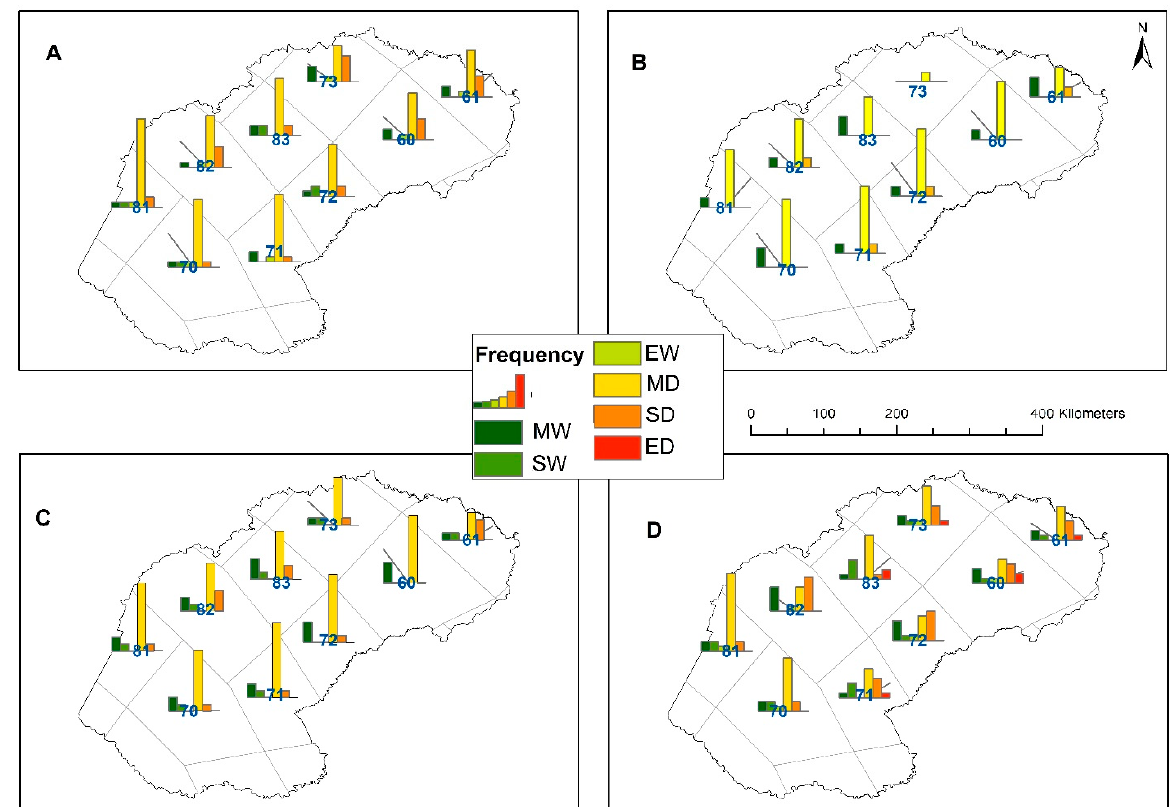
Figure 12. Frequency of EDI, SPI-3, SPI-6, and SPI-12 in the Free State Province from 1980 to 2019: ( A ) EDI; ( B ) SPI-3; ( C ) SPI-6; ( D ) SPI-12 (MW, moderately wet; SW, severely wet; EW, extremely wet; MD, moderately dry; SD, severely dry; ED, extremely dry).